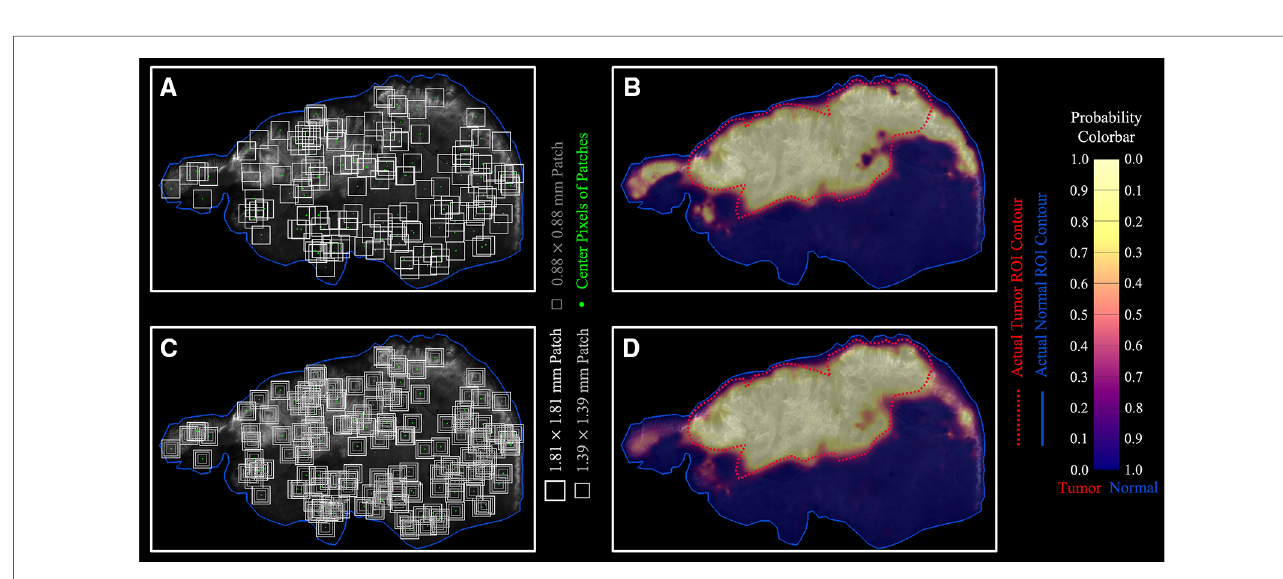
FIGURE 8 Optomics method predicted continuous probability maps. ( A,B ) Single patch size sampling and its probability map. ( C,D ) Three patch size sampling and the combined probability map based on the average probability derived from the three patch